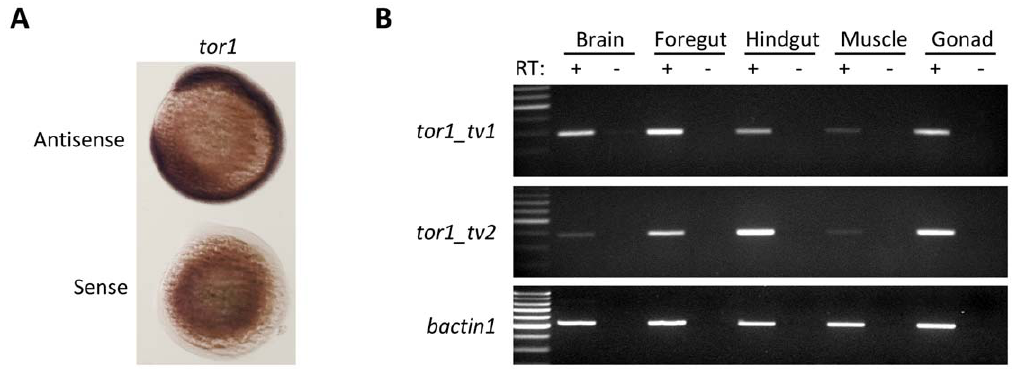
Figure 6. tor1 is expressed ubiquitously. A: RNA i n situ hybridization was employed to detect the tor1 transcript during development. Hybridized probe was detected using a histochemical reaction with a blue/purple product. The photomicrograph shows embryos at 12 hpf; the upper of the pair was hybridized with a tor1 antisense probe and the lower with a tor1 sense control probe. B: Reverse transcriptase PCR was employed to detect tor1_tv1 (upper panel) or tor1_tv2 (middle panel) mRNA in brain, foregut, hindgut, muscle, and gonads of adult zebrafish. Total RNA was treated with reverse transcriptase (RT + ); controls lacking reverse transcriptase (RT - ) excluded amplification of genomic DNA sequences. bactin1 was amplified as a ubiquitously expressed control mRNA (lower panel).